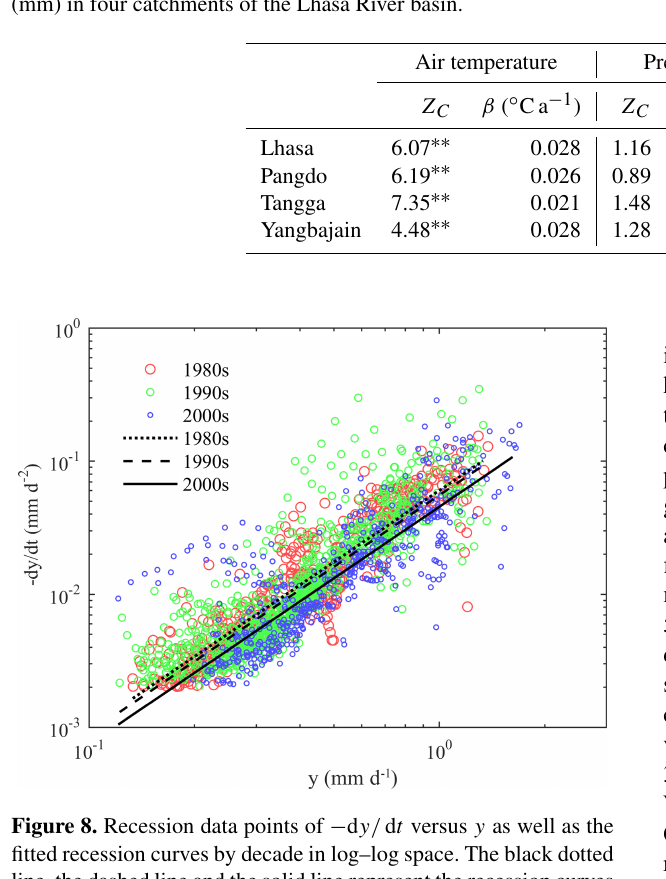
Table 4. Mann–Kendall trend test with trend-free pre-whitening of annual mean air temperature ( ◦ C), precipitation (mm) and streamflow (mm) in four catchments of the Lhasa River basin.